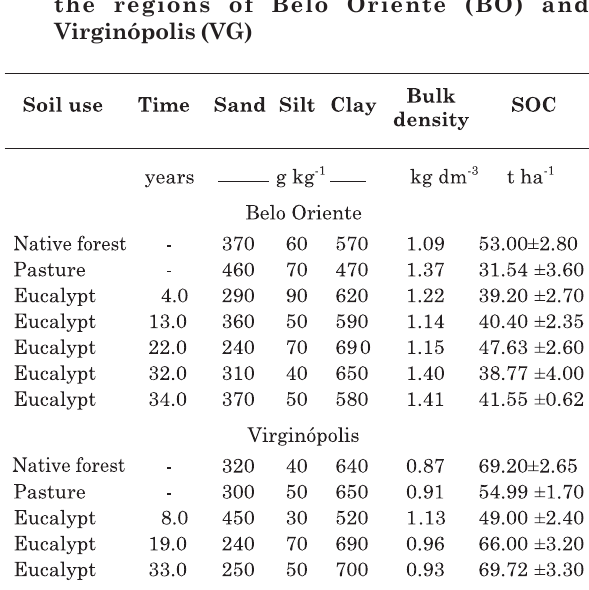
Table 1. Soil use, time under short-rotation eucalyptus, soil physical properties and organic carbon in the 0–20 cm layer of